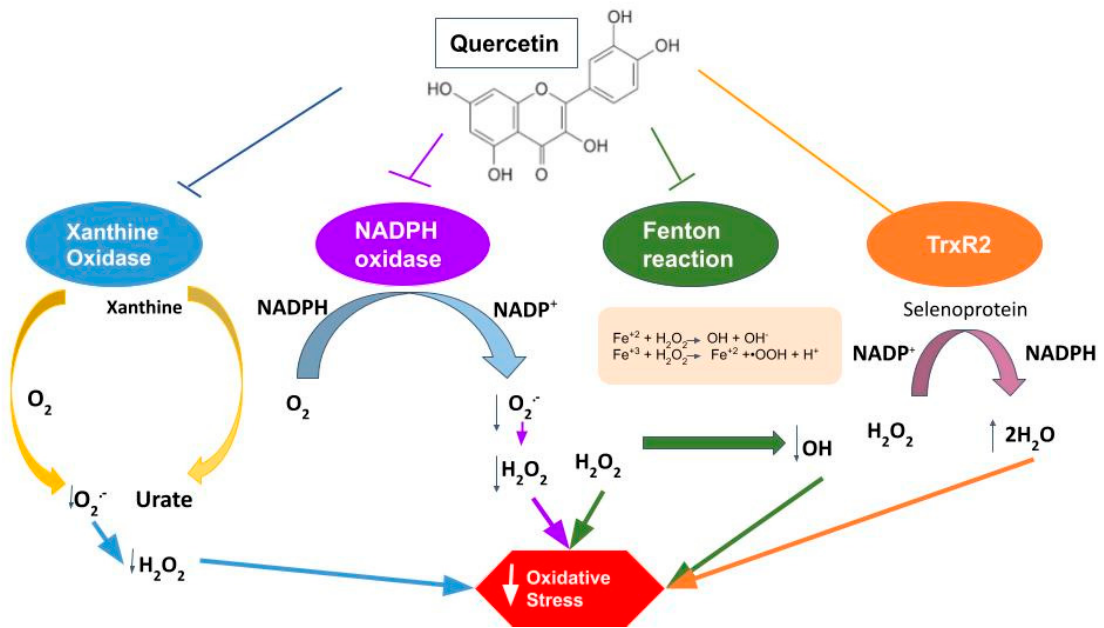
Figure 6. Representation of quercetin cardioprotective effect. Quercetin acts through the inhibition of the enzymes xanthine oxidase, NADPH oxidase and the Fenton reaction, mechanisms leading to a decrease in ROS production. In addition, it acts by activating the selenoprotein TrxR2, which has a powerful antioxidant effect by inactivating ROS. All these mechanisms lead to a decrease in oxidative